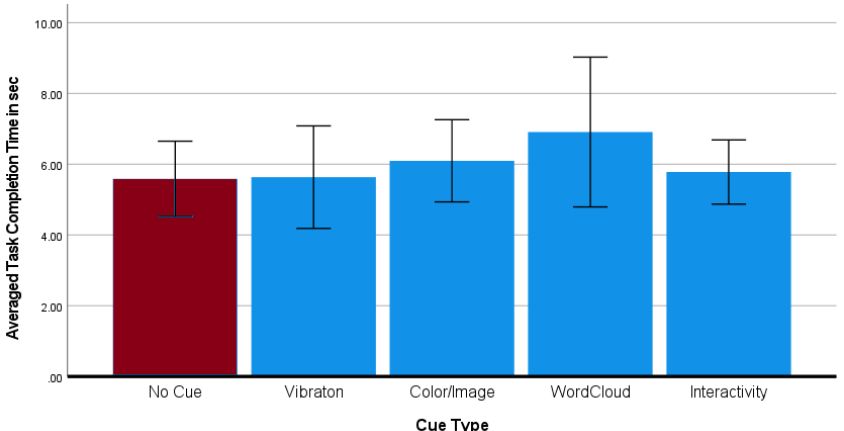
Figure 12. The task completion time for the first five tasks after an interruption in seconds. The completion times are averaged per participant and visualized to compare the four cue designs and the no cue